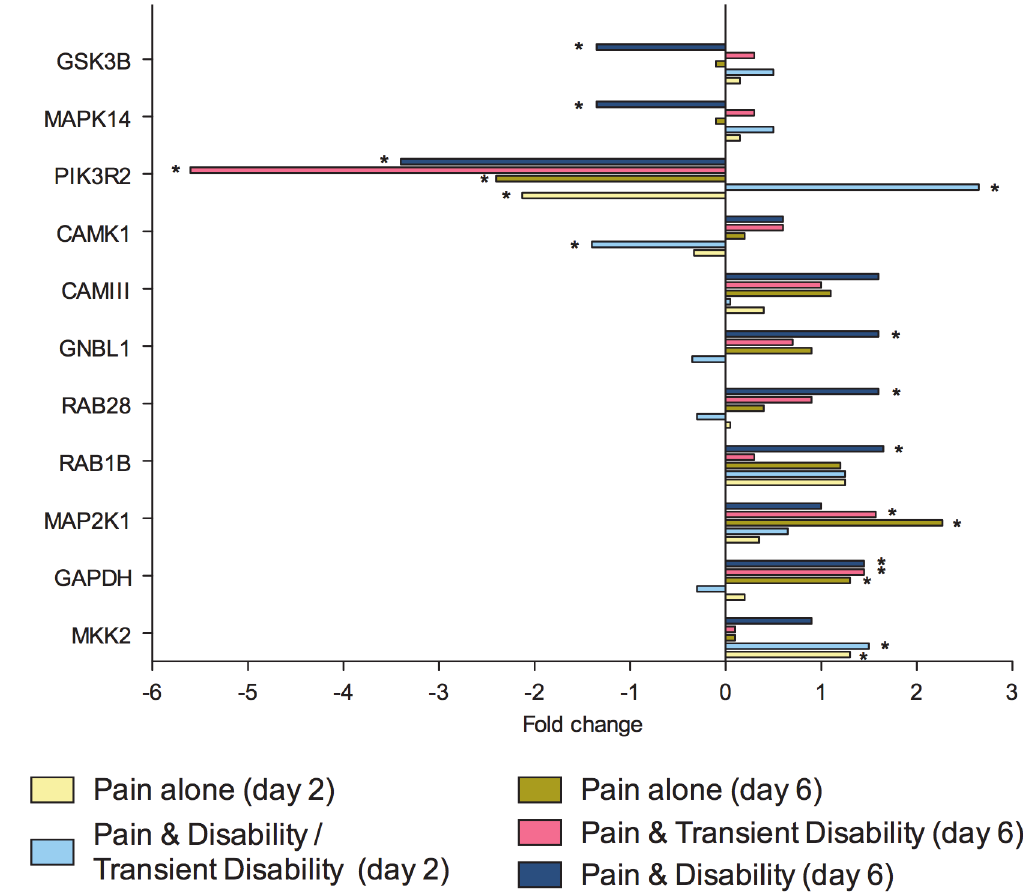
Fig 4. Gene transcripts, which encode for proteins involved in cellular signalling, that are specifically regulated in the lumbar spinal cord after CCI, as determined by microarray analysis. Changes in gene expression have been tested at both 2 and 6 days after CCI on pooled mRNA samples from each disability group. * Indicates up- or down-regulation determined by MAS v5.0.